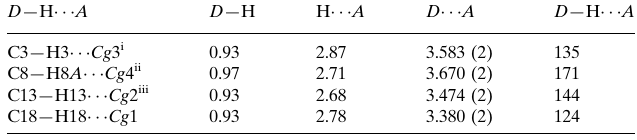
Hydrogen-bond geometry (A˚ , (cid:1)